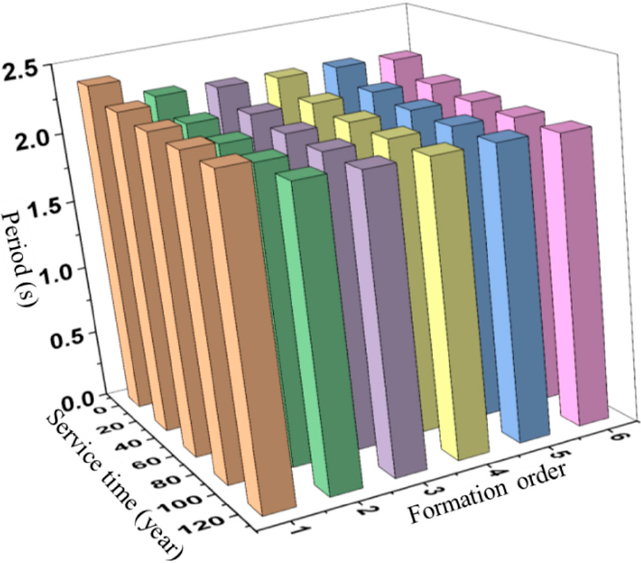
Figure 17. Variation of isolation structure period with service time and vibration mode under LRB deterioration.